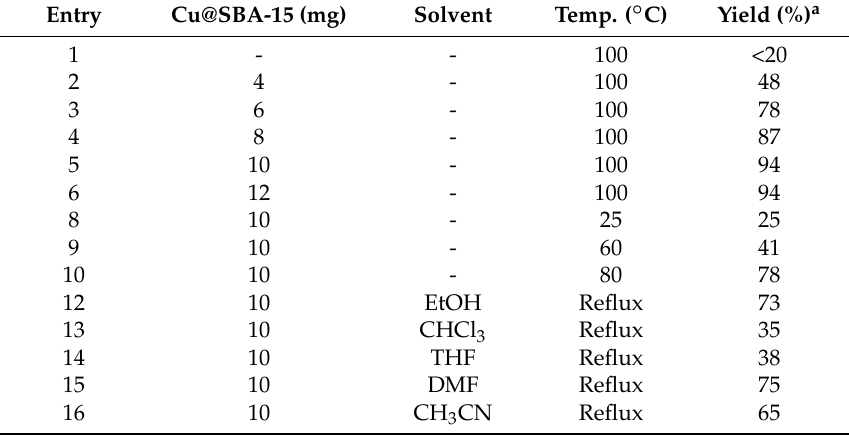
Table 1. Effects of different parameters on the Biginelli reaction of ethyl acetoacetate (5 mmol), benzaldehyde (5 mmol), urea (6 mmol).